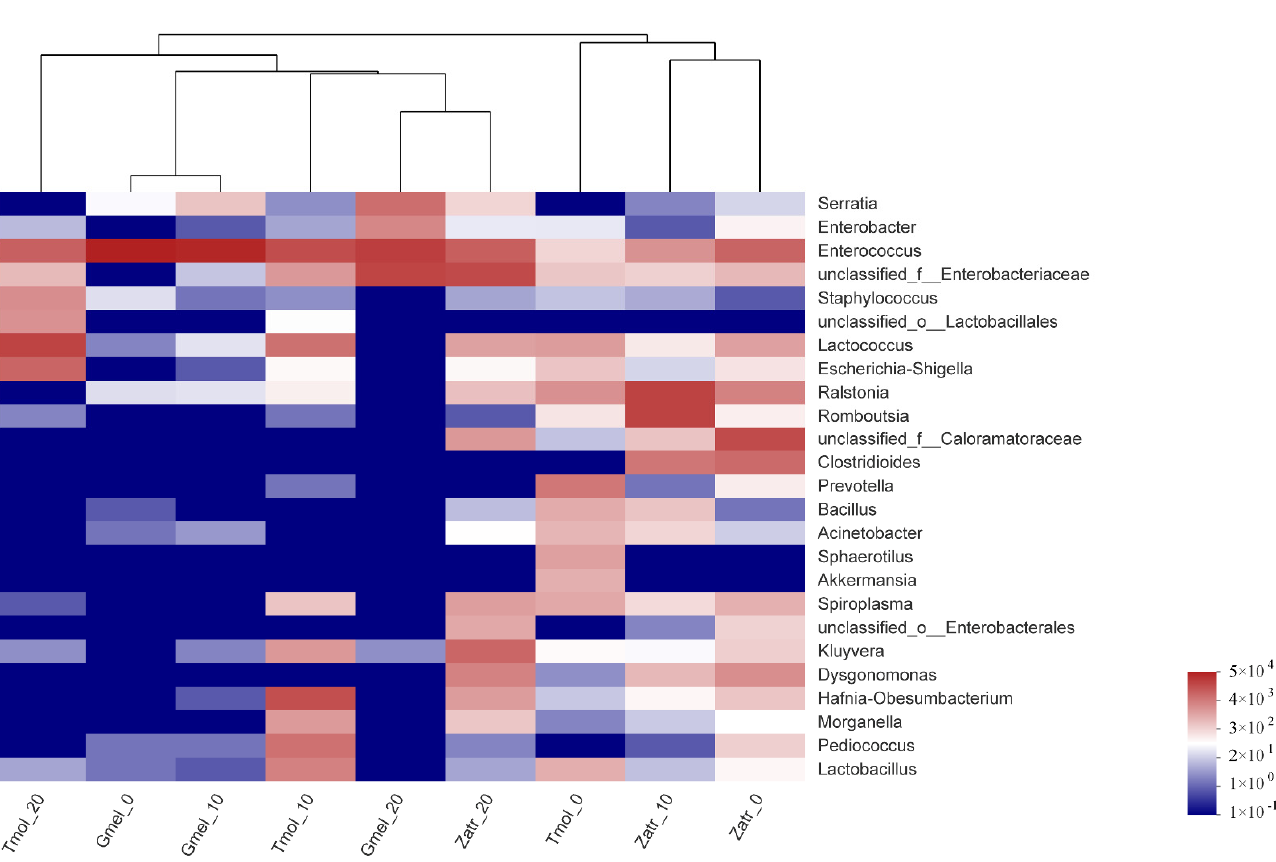
Figure 4. Community bar plot analysis of nine samples of the three species’ larvae based on genus ( a ) and phylum levels